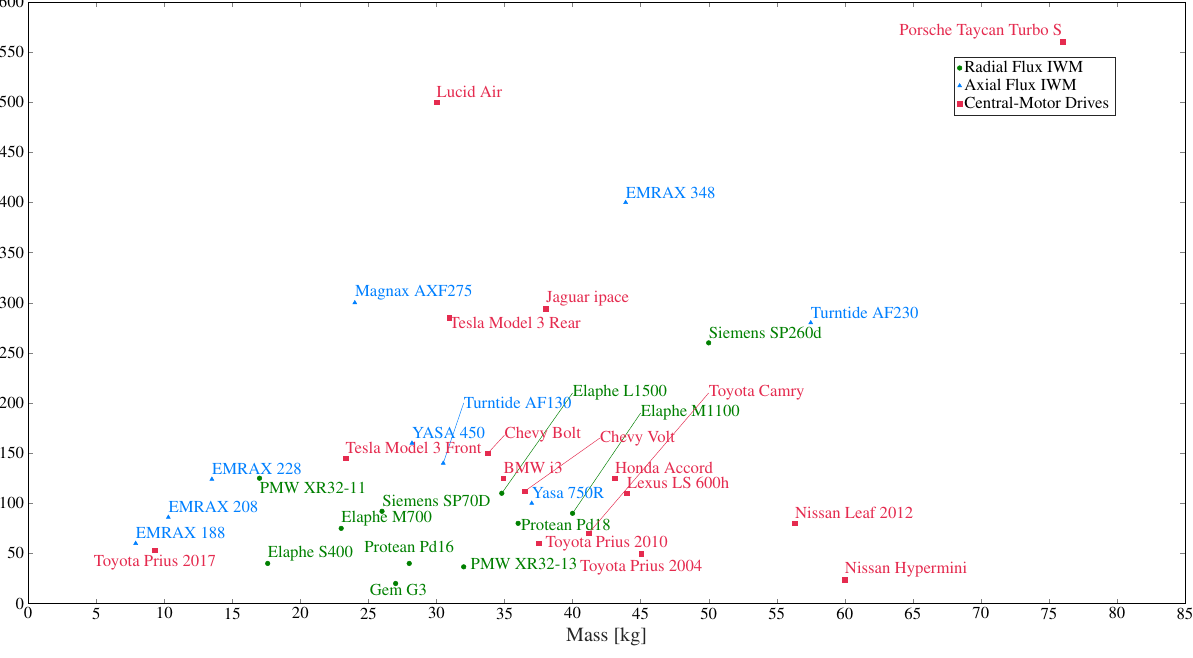
Figure 11. Power vs. mass trend of commercially available radial flux IWM, axial flux IWM, and central-motor drives for